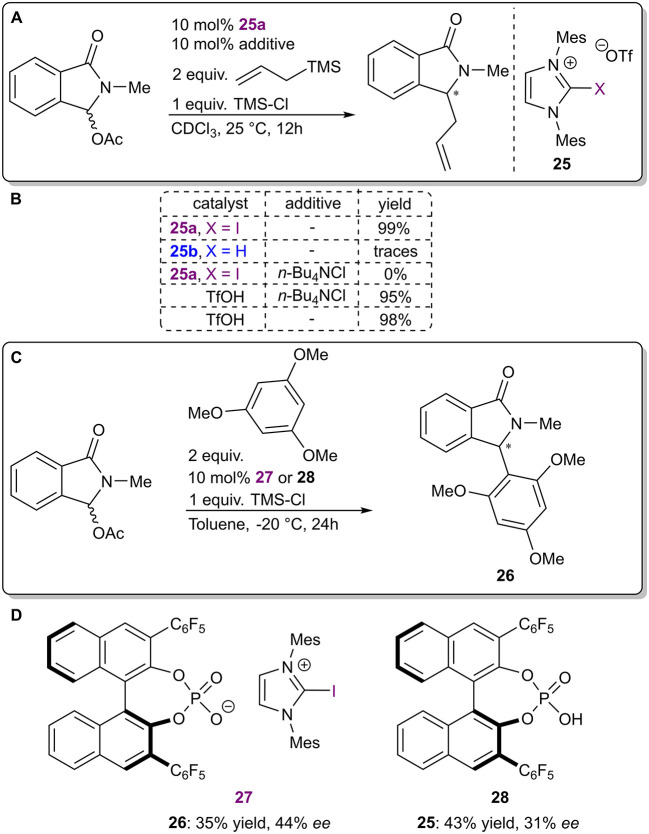
(A) Iodo-imidazolium triflate-catalyzed nucleophilic addition to α-oxo-lactams; (B) control experiments used to determine the influence of the halogen atom; (C) reaction conditions used in the asymmetric variant; (D) catalytic systems used in the asymmetric reaction.